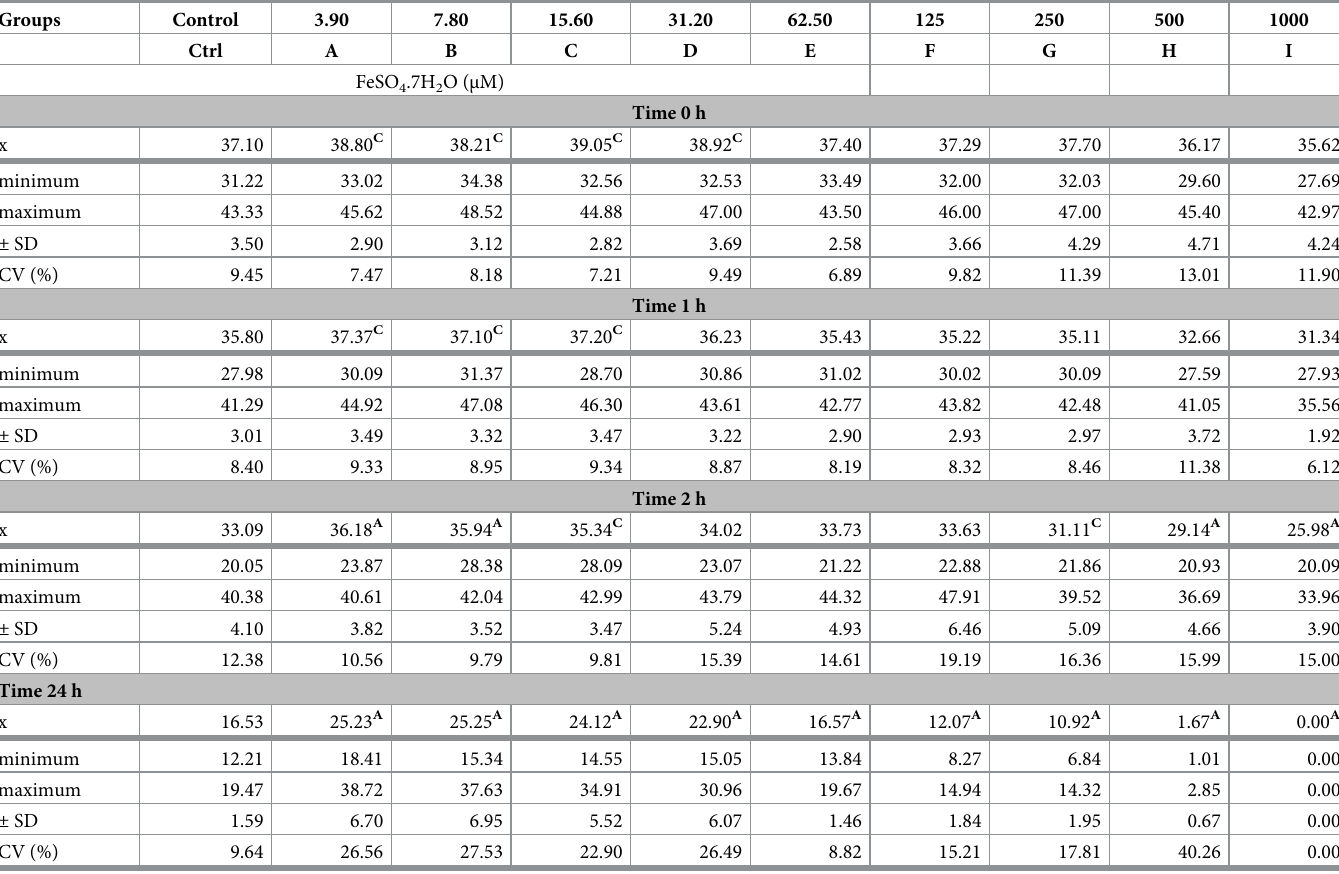
Table 4. Distance average path of spermatozoa ( μ m) exposed to FeSO 4 .7H 2 O in different time periods. Groups Control